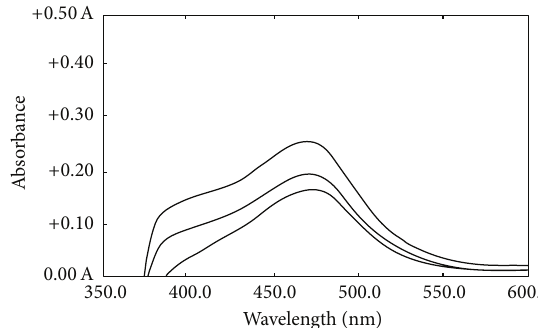
Figure 3: Absorption spectra of Cu-MNDTT complex in three concentrations, 15, 17.5, and 20 𝜇 g/mL.